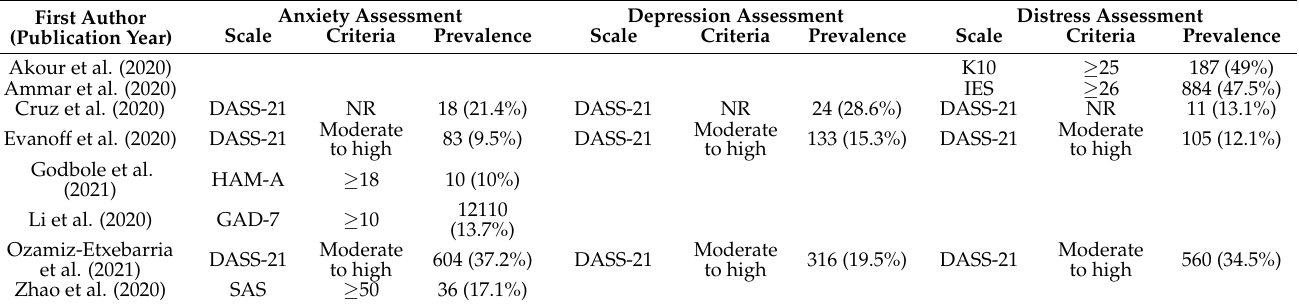
Table 2. Outcome assessments of the included studies.